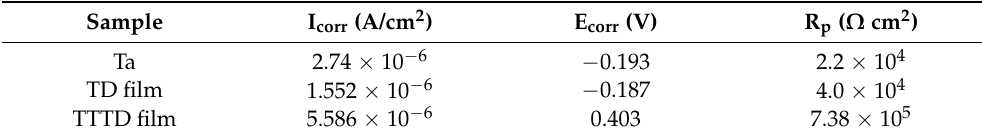
Figure 9. Fitted equivalent circuit diagram in weak alkaline solution: ( a ) TD film ( b ) TTTD film. Here , Rs is the solution resistance between the DLC film and the electrode, Q1 is the capacitance of the DLC film, R1 is the conduction resistance of the solution passing through the voids and de- fects of the DLC film, R2 is the conduction resistance of the passivation film voids and defects, Q2 is the capacitance of the passivation film, R3 is the polarization resistance between the film and the substrate, and Q3 is the electric double layer capacitance generated by the solution reaching the interface between the film and the substrate.